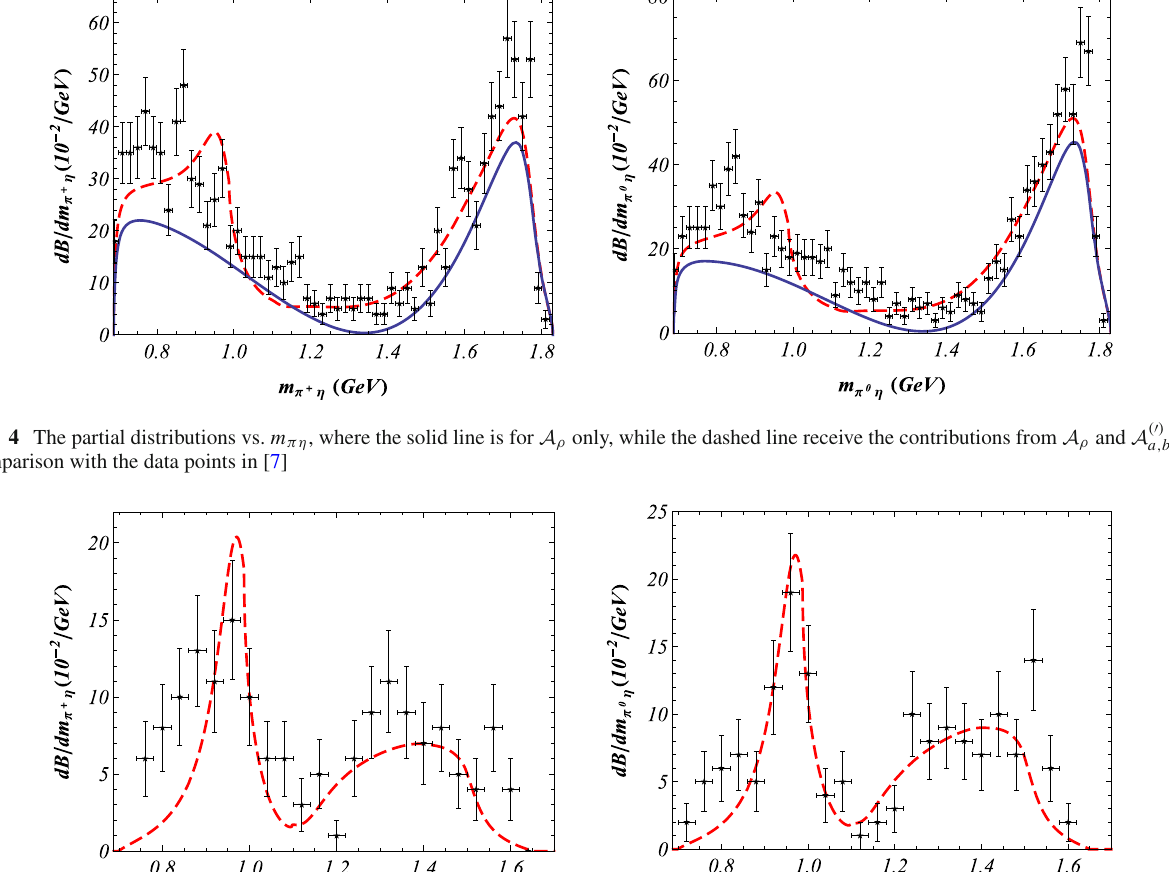
Fig. 5 The partial distributions vs. m πη with the cut of m π + π 0 > 1 . 0 GeV, in comparison with the data points in